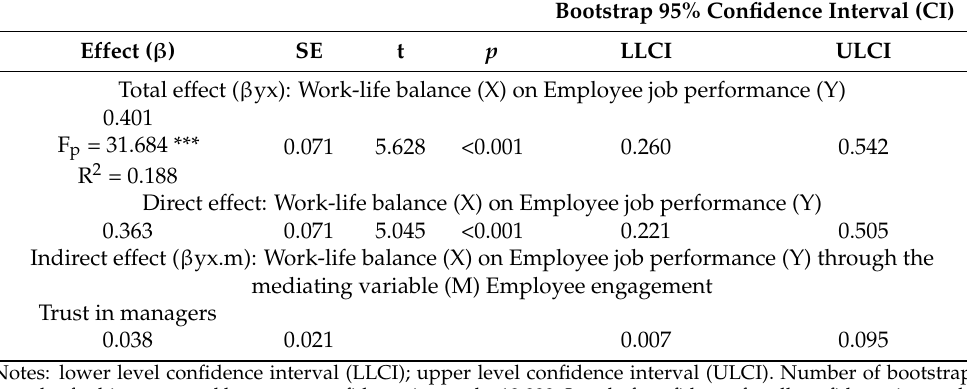
Table 7. Total, direct and indirect links between work-life balance and employee job performance through employee engagement.